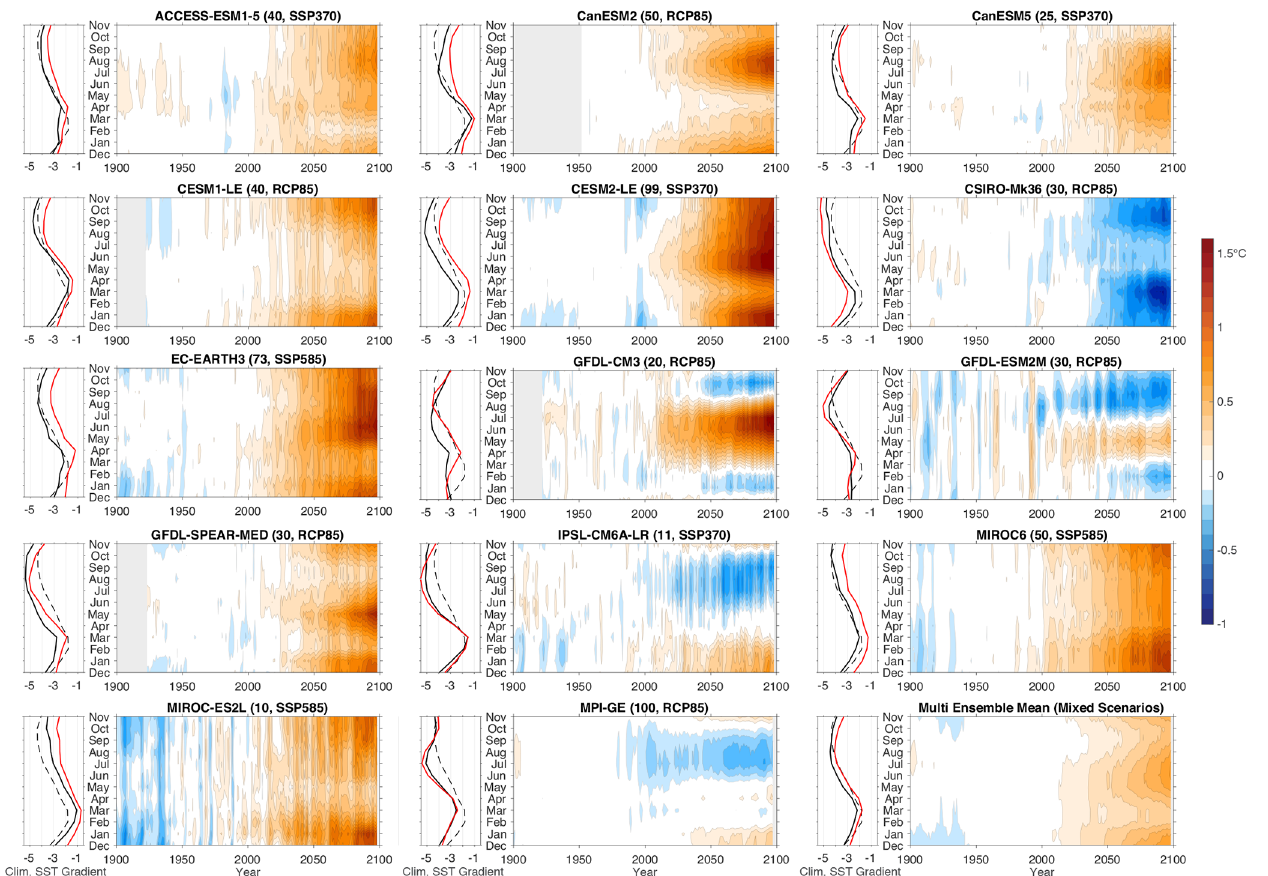
Figure 7. Tropical Pacific SST gradient climatology and mean-state changes, taken as the ensemble mean difference between the eastern equatorial Pacific (90–150 ◦ W, 5 ◦ S–5 ◦ N) and the western equatorial Pacific (120–180 ◦ E, 5 ◦ S–5 ◦ N) for each large ensemble and the multi-ensemble mean (see Fig. 6 for region outlines). Black lines show the climatology in 1951–1980, shading shows the 5-year running- mean anomalies with respect to 1951–1980, and red lines show the climatology in 2070–2099. Black dashed lines show the observational climatology based on ERSST5 in the period 1951–1980. Red anomalies show El Niño-like changes, and blue anomalies show La Niña-like